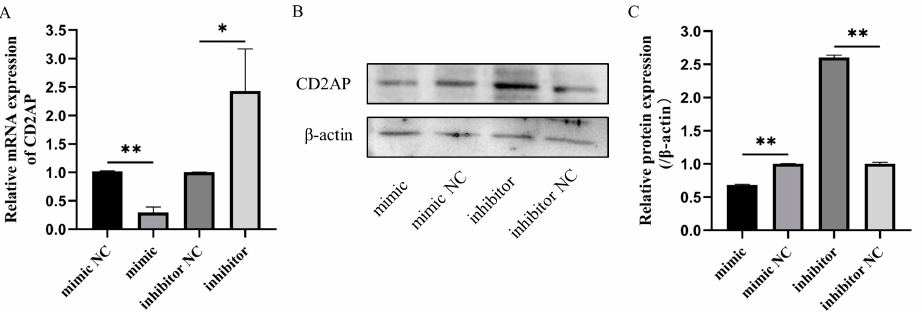
Figure 8. Bta-miR-199a-3p negatively regulates the mRNA and protein expression of CD2AP in the MAC-T cells. ( A ) Effect of overexpression or inhibition of bta-miR-199a-3p on CD2AP mRNA expression. ( B , C ) Effect of overexpression or inhibition of bta-miR-199a-3p on CD2AP protein expression: ( B ) is the result of Western blot, and ( C ) is the image analysis result of ( B ) (with β -actin as the standardized correction). * refers to p < 0.05, ** refers to p <